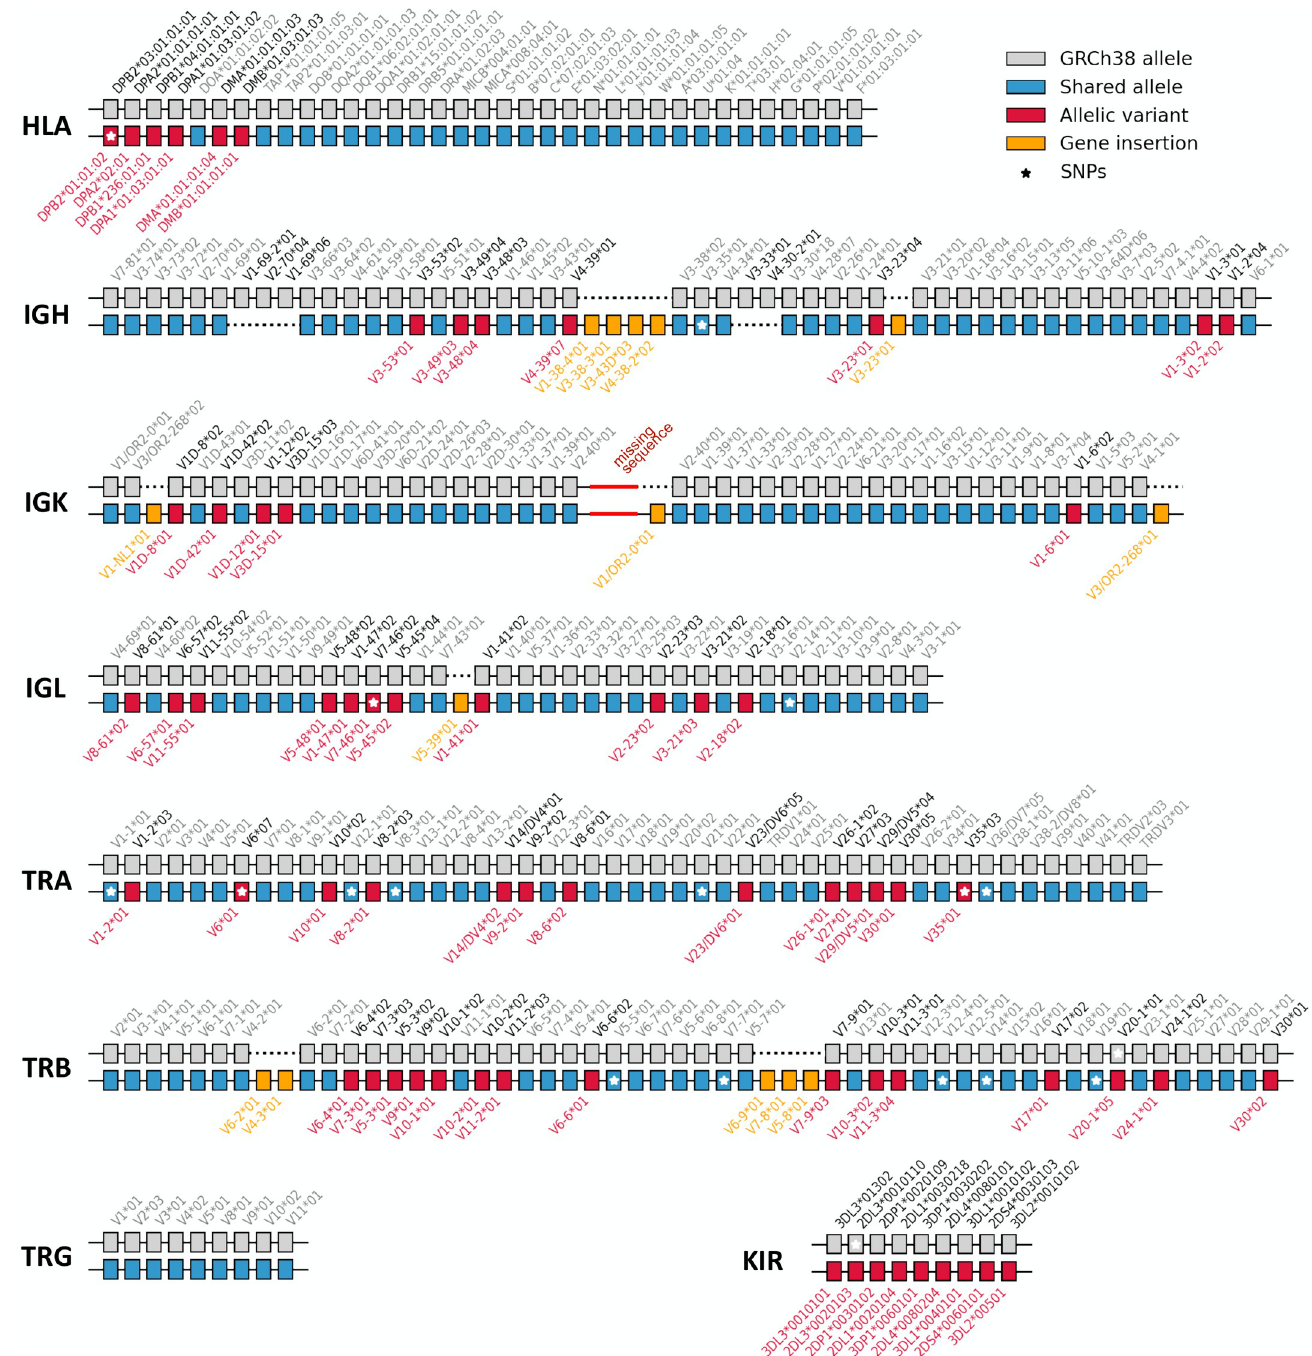
Fig 4. HV31 assembly content of immunoglobulin and T cell receptor variable (V) genes compared with GRCh38. Pseudogenes are not shown. V genes in each region are arranged according to their relative order on the positive-sense strand. Allelic variants refer to genes where the best-matching HV31 allele differs from the GRCh38 allele. Insertions refer to genes in the HV31 assembly that cannot be matched to a GRCh38 gene. Alleles with identical sequences, such as TRBV6-2 � 01 and TRBV6-3 � 01 , are not distinguished. Alleles that carry additional SNPs compared to the best-matching reference allele are marked with stars. The sequence fragment between IGK proximal and distal clusters that remains not fully resolved is denoted as a red line.